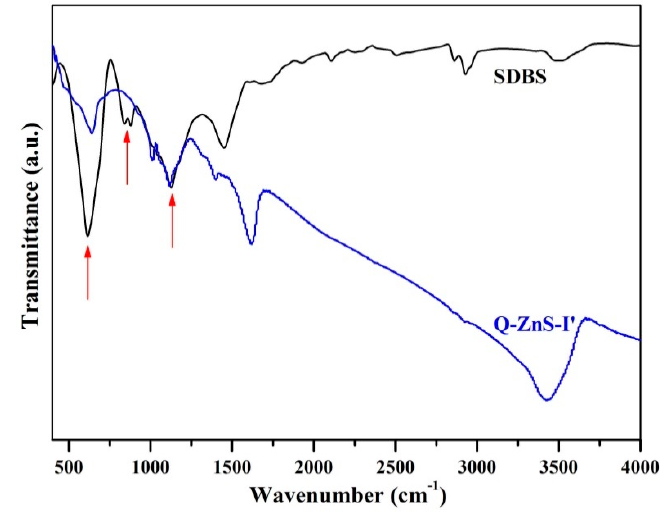
Figure 4. FT-IR spectra of SDBS and Q-ZnS-I ʹ .